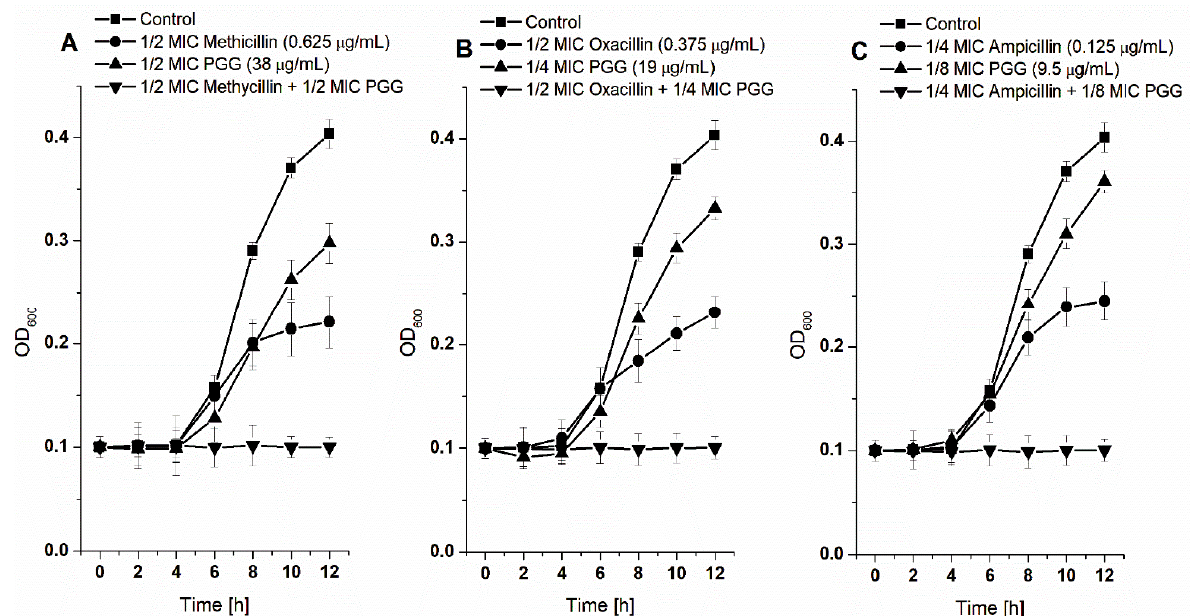
Figure 2. Growth curves of S. aureus 8325-4. Bacteria were grown at sub-inhibitory concentrations of PGG alone, antibiotic alone (methicillin ( A ), oxacillin ( B ), ampicillin ( C )), and in combination. The data presented are the means ± SD, n = 6.